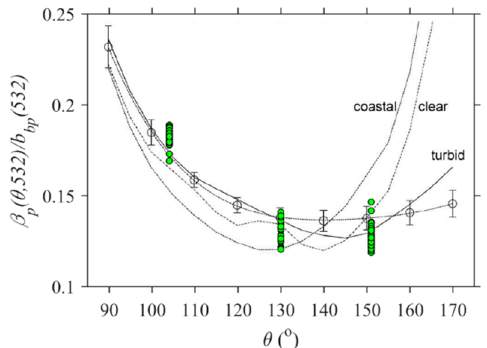
Figure 9. Mean spectra across geomorphic reef zones for absorption by CDOM ( A ), sediments ( B ), phytoplankton ( C ), and particulate attenuation ( D ).